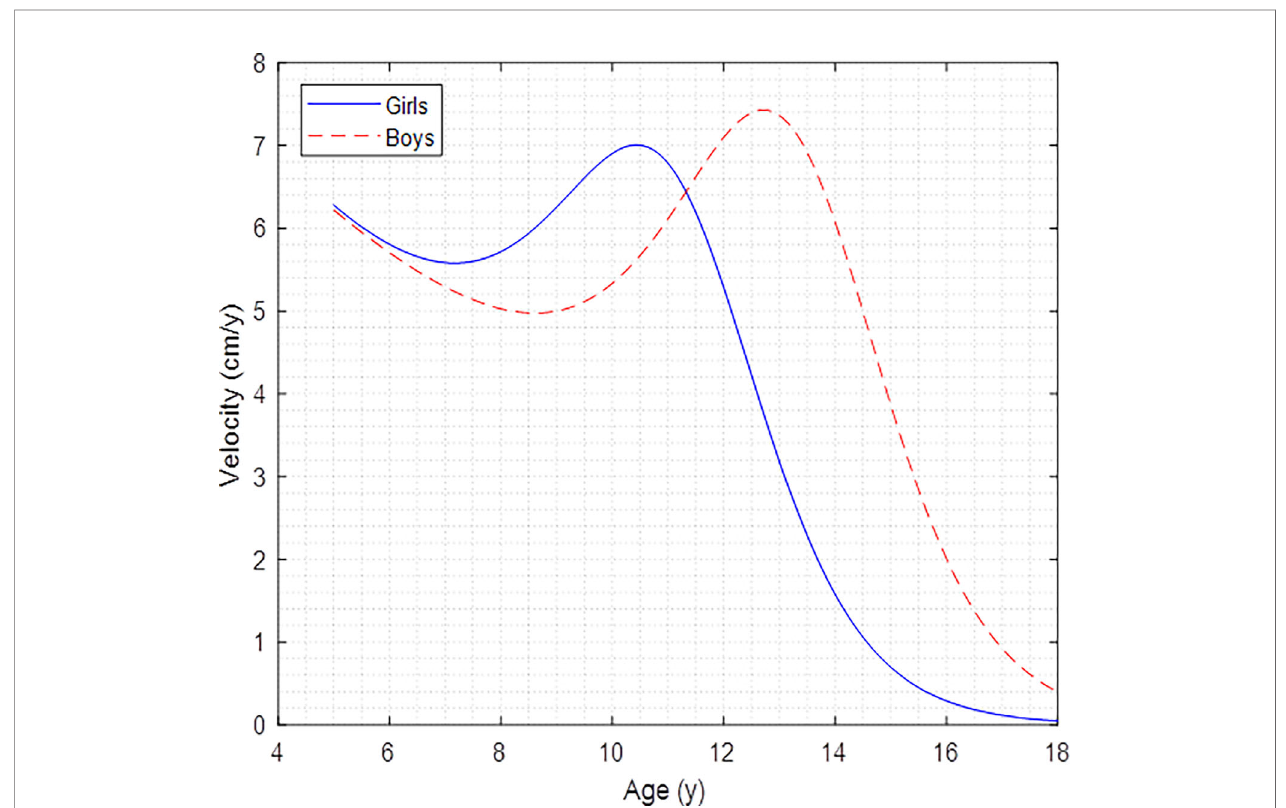
FIGURE 2 | Peak height velocity curves of Colombian children and adolescents of both